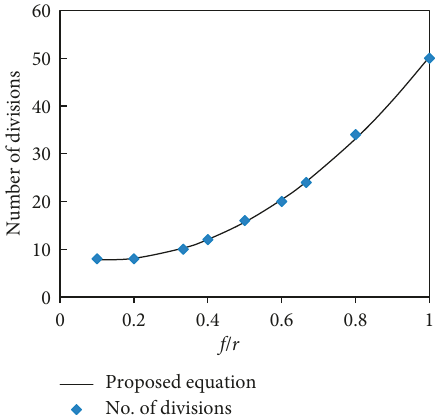
Figure 11: Proposed equation for predicting the required number of integral divisions.